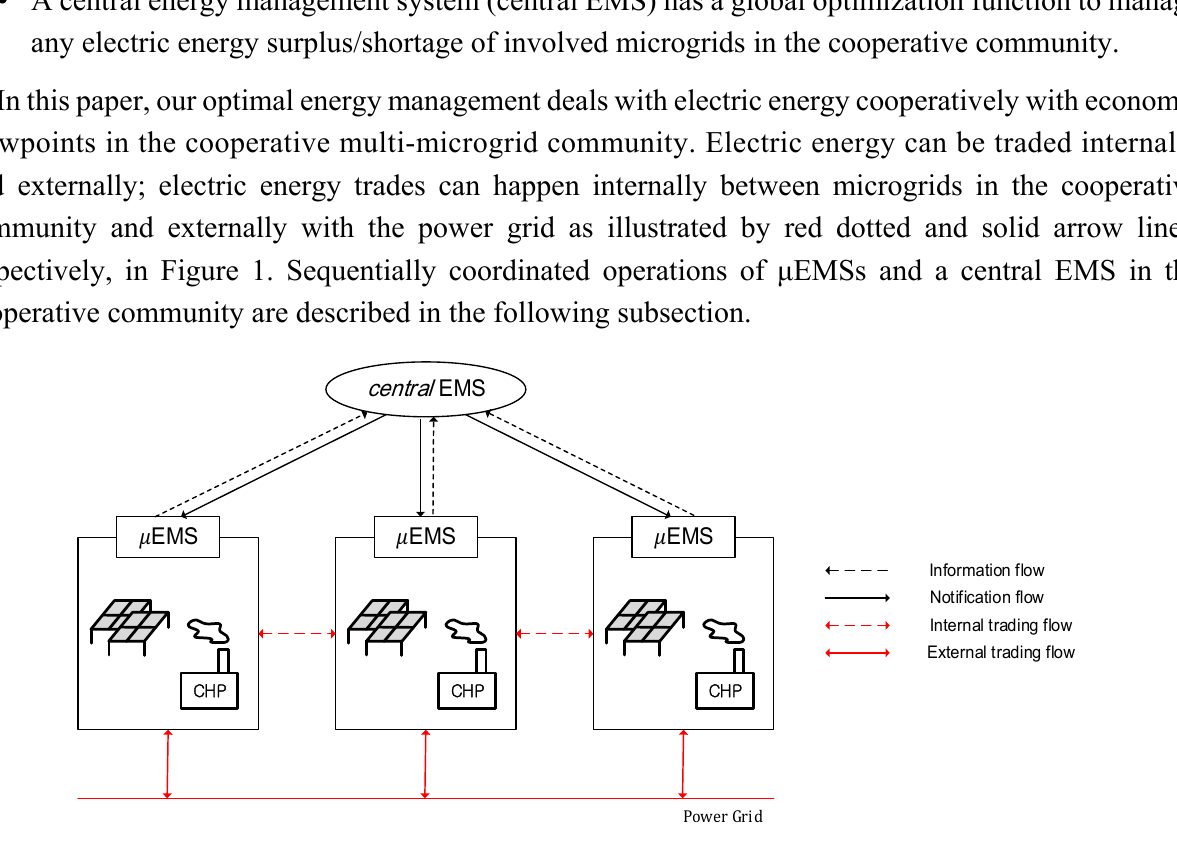
Figure 1. Information and energy flows in cooperative multi-microgrid